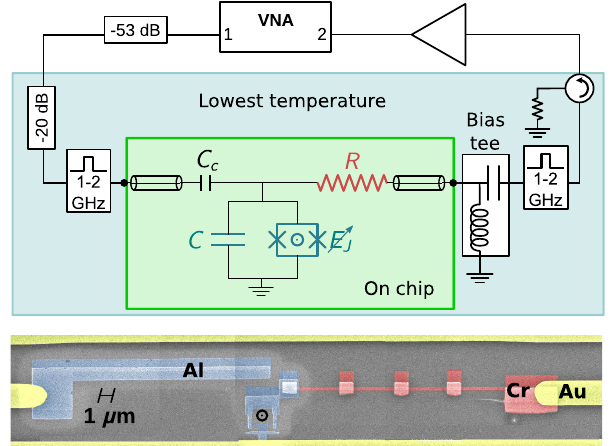
FIG. 2. Top: Simplified schematics of the experimental setup. Bottom: One of the samples measured. Two SEM micrographs are stitched to show the entire central part and colorized to evidence the different metals used (see Appendix B for fabrica- tion details).